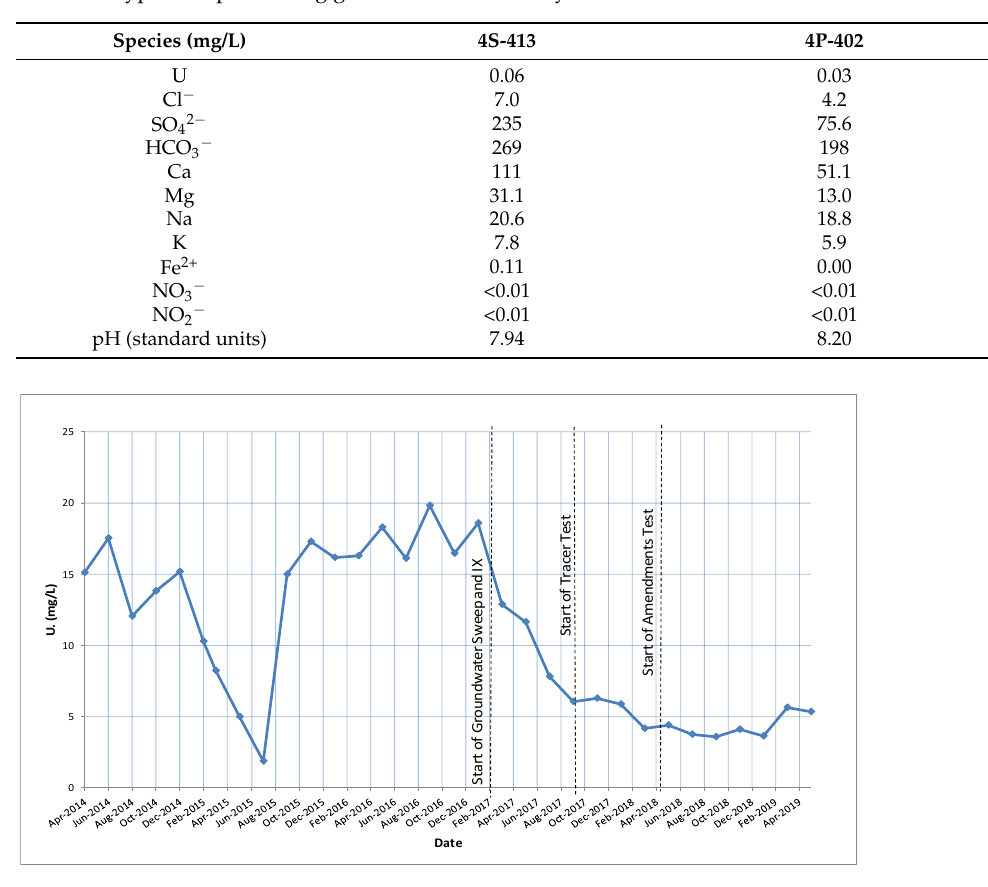
Table A4. Major and minor ion chemistry in two background monitoring wells in mining unit 4, which are typical of pre-mining groundwater chemistry in ore zones.